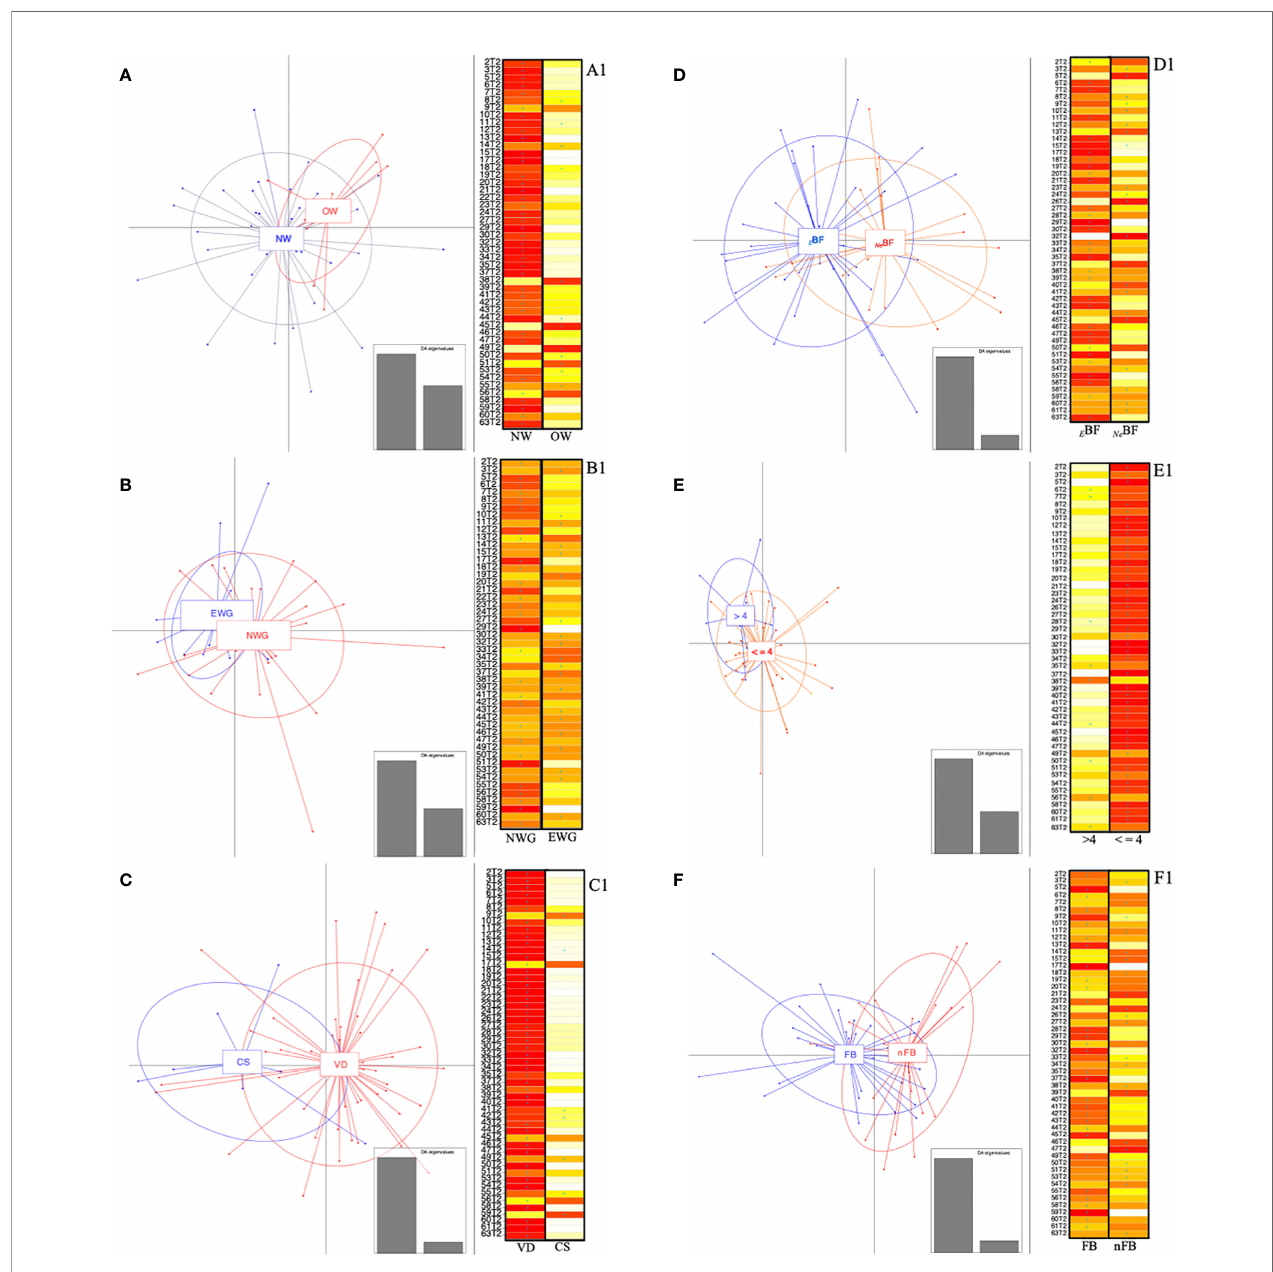
FIGURE 6 | Discriminant analysis of principal components (DAPC) and relative score-plots. (A – F) report the DAPC score plots based on the relative abundances (16S rRNA gene amplicon) of genera with median values >0.1% found in infants at 6 months. Panel: (A) NW, normal BMI (<25 kg/m 2 ); OW, women overweight/ obesity (BMI ≥ 25 kg/m 2 ); (B) NWG, optimal weight gain; EWG, excessive weight gain; (C) VD, vaginally delivered; CS, delivered by cesarean section; (D) BF, exclusive breast-feeding; FF, combined or exclusive formula-feeding; (E) ≤ 4, infants weaned before 4 months of age; >4, infants weaned after 4 months of age. Panel (F) FB, fi rst-born; nFB, not fi rst-born. (A1 – F1) respectively indicate whether the infants (rows) could be assigned based on discriminant functions by K-means analysis. The cell colors represent the membership probabilities (K-means analysis) to belong to each cluster (red=1, orange=0.75, yellow=0.25, white=0) and blue crosses indicate the originally belonging